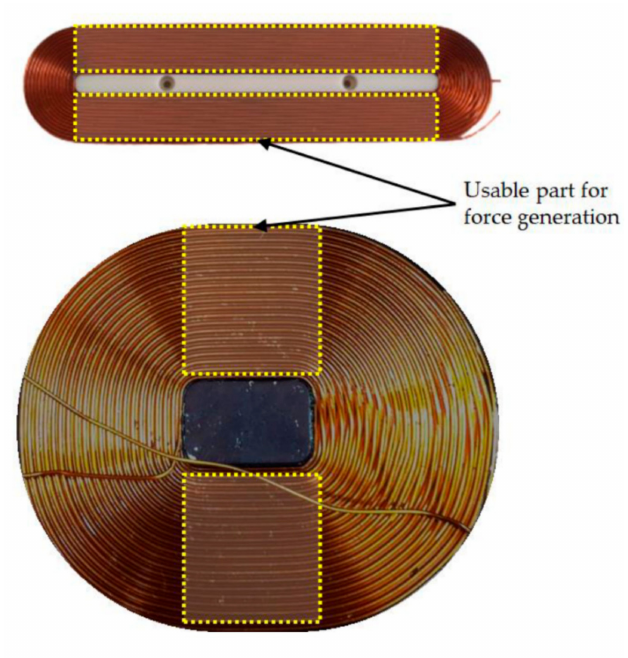
Figure 7. Usable part of VCM coils for force generation, an example of normal winding ( top ) and an example of abnormally enlarged winding in the width direction ( bottom